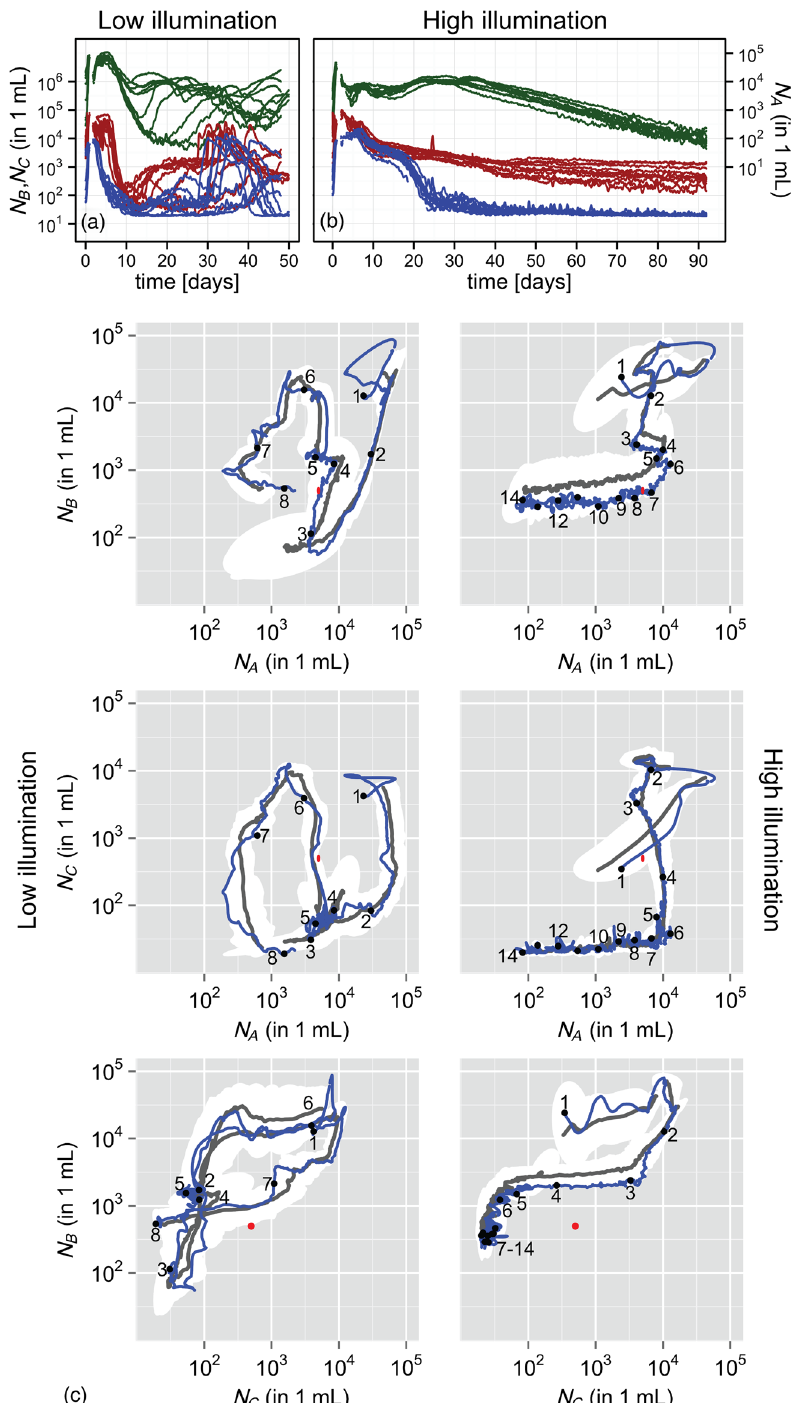
FIG. 2. Population time series and phase portraits at low and high illuminations. (a) Time series of population dynamics for 10 replicate ecosystemsat I ¼ 0 . 25 I 0 illuminance.Green( A — algae,rightaxis): C.reinhardtii ;red( B — bacteria): E.coli ;blue( C — ciliate): T.thermophila . (b) Time series for 10 replicates at I ¼ I 0 , as in (a). (c) Population dynamics are plotted as trajectories in the space of one species abundance versus another, for two illumination conditions: left column, I ¼ 0 . 25 I 0 [low illumination, 10 replicates, Figs. 1(e) and 2(a)]; right column, I ¼ I 0 [high illumination, 10 replicates, Figs. 1(d) and 2(b)]; top row, E. coli vs C. reinhardtii ; center row, T. thermophila vs C. reinhardtii ; bottom row, E. coli vs T. thermophila . Gray curve, geometric mean trajectory over replicates; white region, 68% confidence interval of logarithmic abundance over replicates; blue curve, trajectory for a single replicate; red ellipse, 95% confidence interval for initial inoculation abundance; numbered points,timingalongtrajectoryinweeks,startingat the beginningofweek1.The typical timebetweeninoculationandthe first labeled point was 20